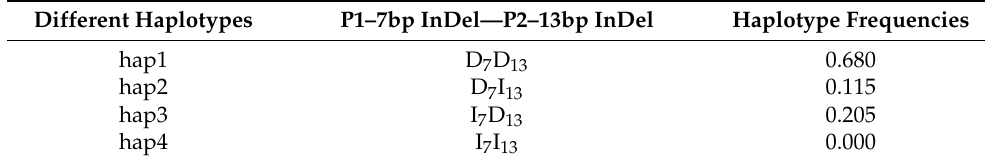
Table 2. Haplotypic frequencies within the AKAP12 gene in Shaanbei white cashmere goats. Different Haplotypes